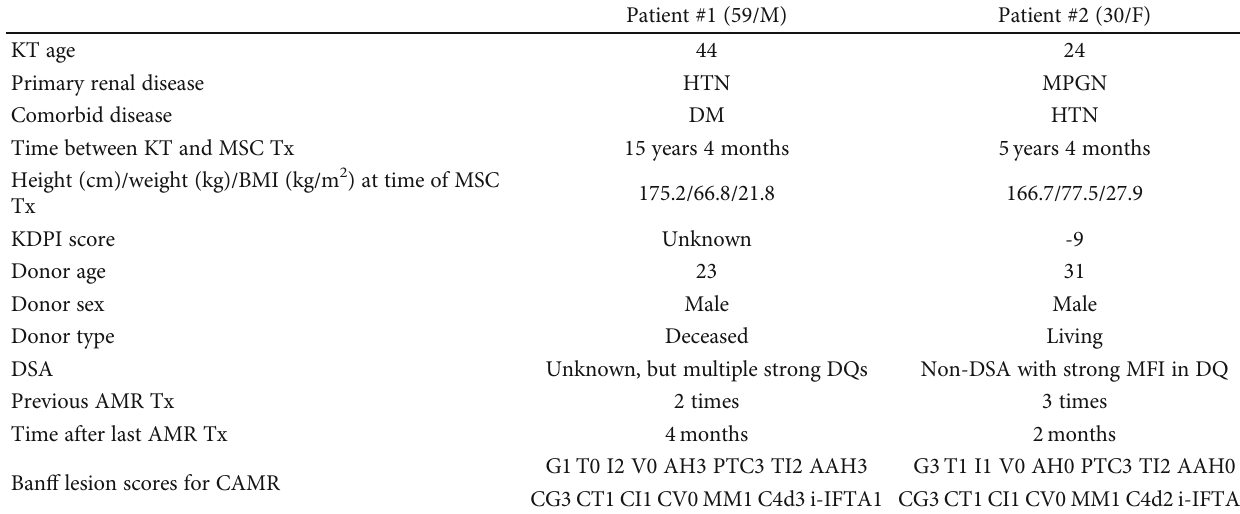
Table 1: Features of the patients.